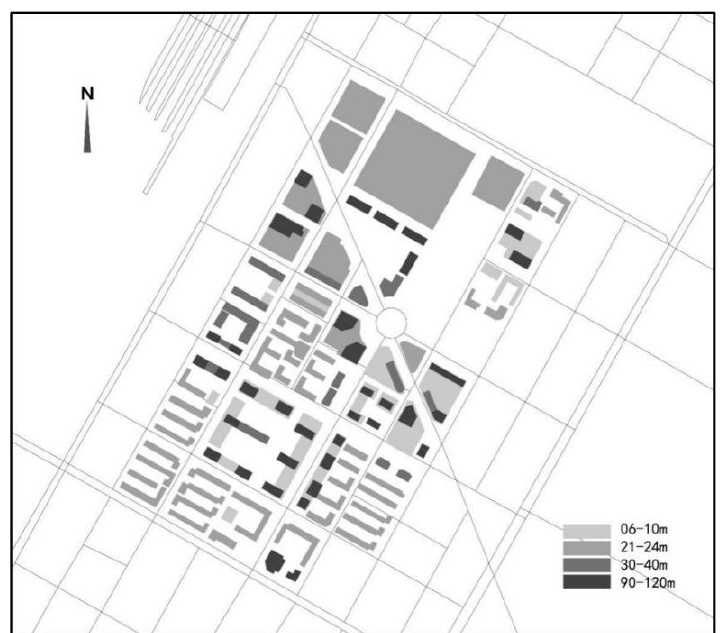
Figure 2. Layout of the example—Taiyuan urban block.